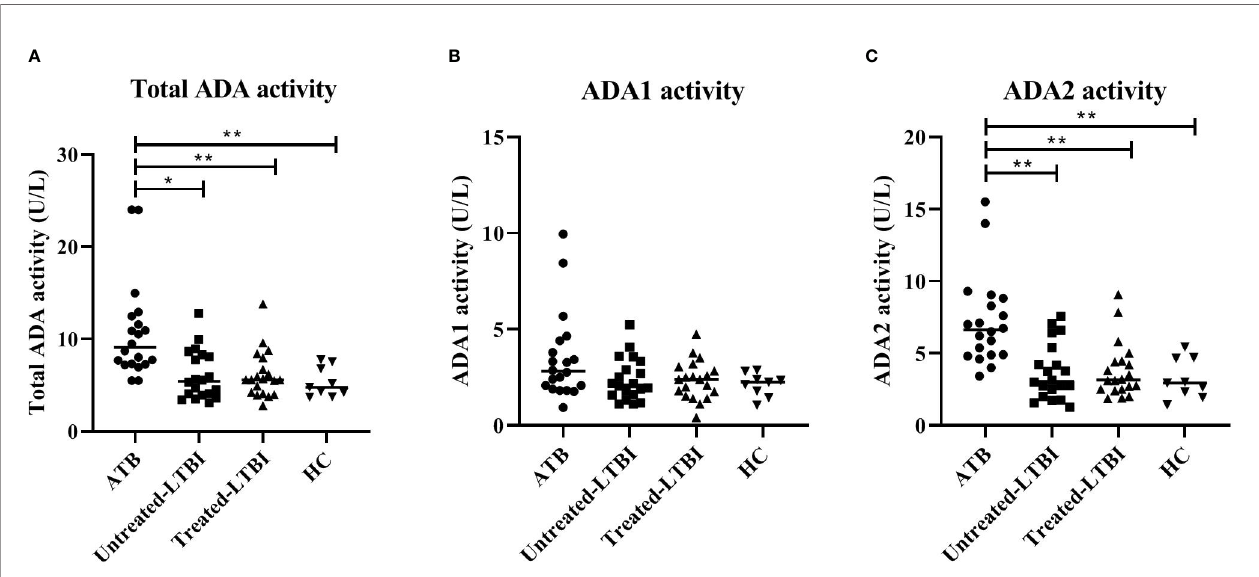
FIGURE 3 | ADA activity levels in serum of individuals with ATB, untreated LTBI, and treated LTBI and HCs. Serum levels for total ADA (A) , ADA1 (B) , and ADA2 (C) activity levels are shown. All groups were compared for each marker using Mann – Whitney U tests. In panels (A – C) , the fi lled dots represent participants with ATB, the fi lled squares represent the participants with untreated LTBI, the fi lled triangles represent the participants with treated-LTBI, and the fi lled inversed triangles represent the HCs. The horizontal line in each study group represents the median concentration. ADA, adenosine deaminase; ADA1, adenosine deaminase-1; ADA2, adenosine deaminase-2; ATB, active tuberculosis; LTBI, latent tuberculosis infection. * 0.001 < p < 0.05, ** p <